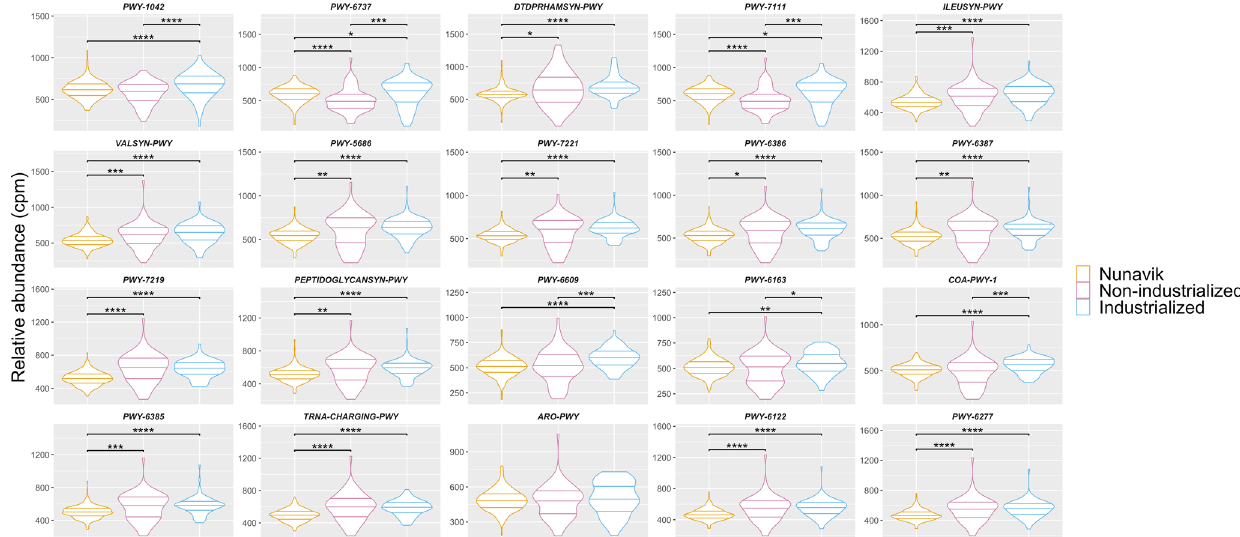
Fig. 6 Top 20 most abundant pathways in the gut microbiome compared to individuals from non-industrial and industrial societies. Violin Plots represent the relative abundance (copies per million) of top 20 pathways in the Nunavik gut microbiome in comparison to non-industrialized and industrialized groups (Wilcoxon-Mann-Whitney; *: p -value ≤ 0.05, ** p -value ≤ 0.01, ***: p -value ≤ 0.001, ****: p -value ≤ 0.0001). (PWY-1042 = PWY- 1042: glycolysis IV (plant cytosol), PWY-6737 = PWY-6737: starch degradation V, DTDPRHAMSYN-PWY = DTDPRHAMSYN-PWY: